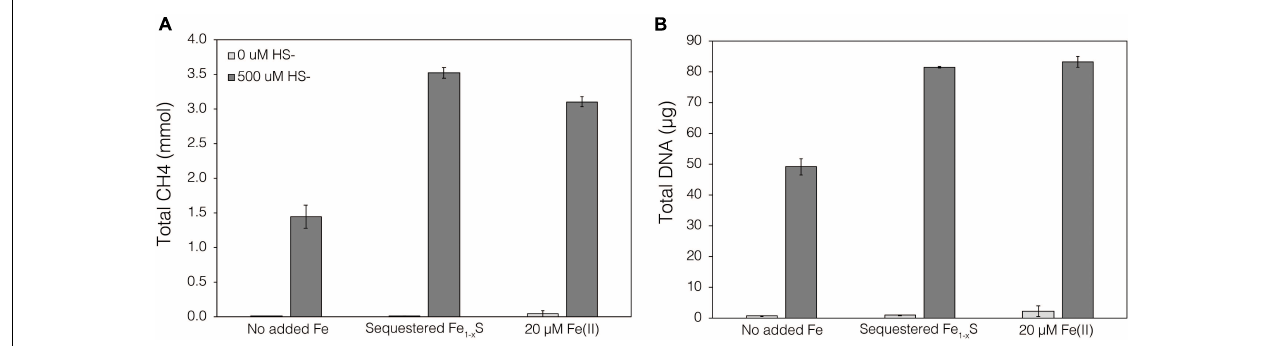
FIGURE 7 | Production of (A) total CH 4 and (B) total biomass (DNA) of M. barkeri Fusaro wild-type grown with no added Fe (No added Fe), with 0.1 g specimen pyrrhotite